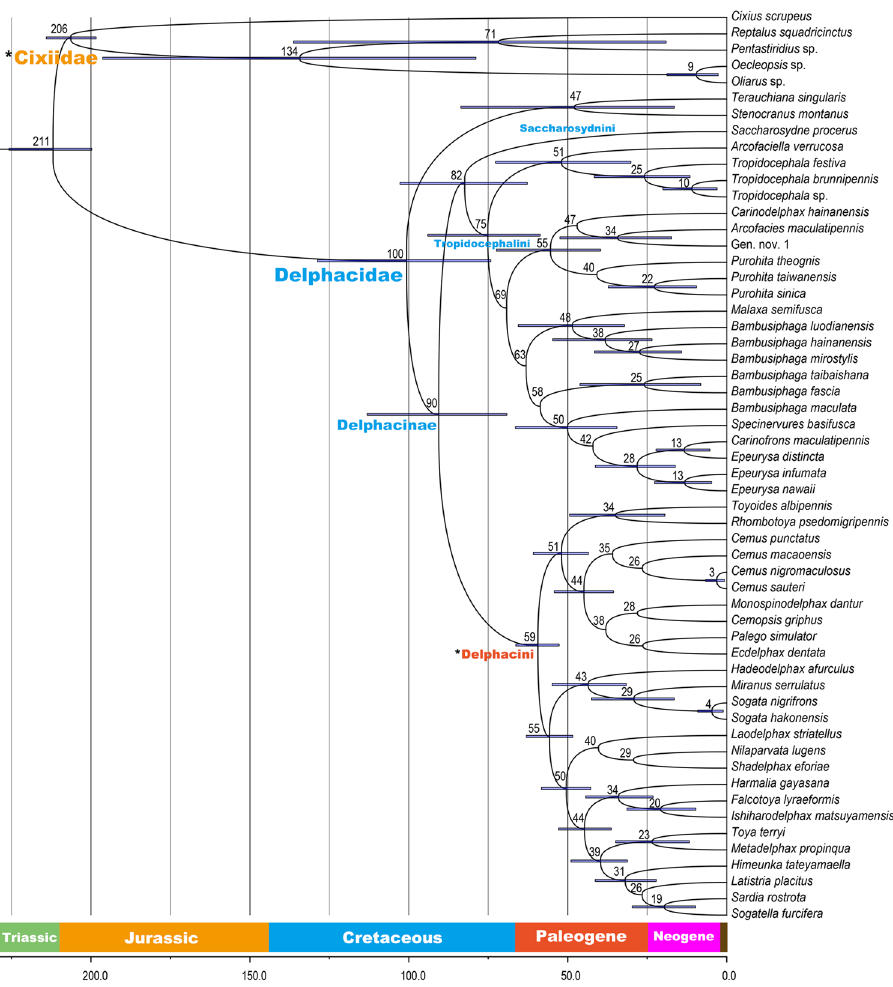
Figure 2. Chronogram of Delphacinae divergence time estimated from the BEAST analysis with a Bayesian relaxed lognormal clock. The numbers at nodes indicate the mean ages and blue bars represent 95% highest posterior density intervals for the node ages. Two calibration points are indicated as * Cixiidae and *